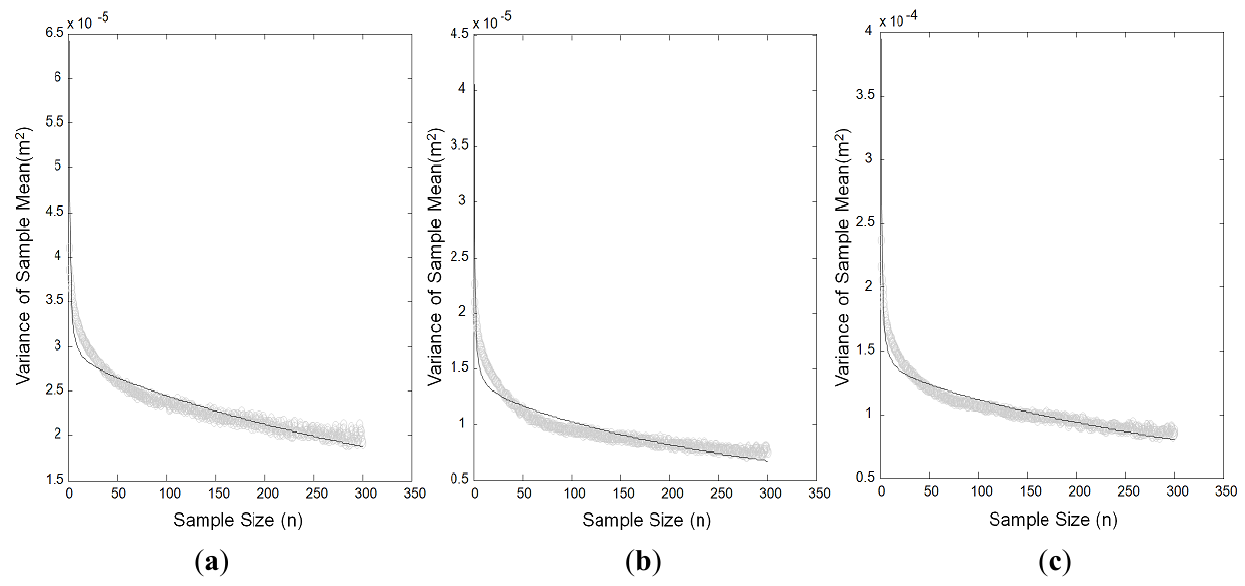
Figure 8. Variances of the sample mean were calculated from the observation values and estimated using the least square method. ( a ) North coordinates. ( b ) East coordinates. ( c ) Ellipsoidal heights.